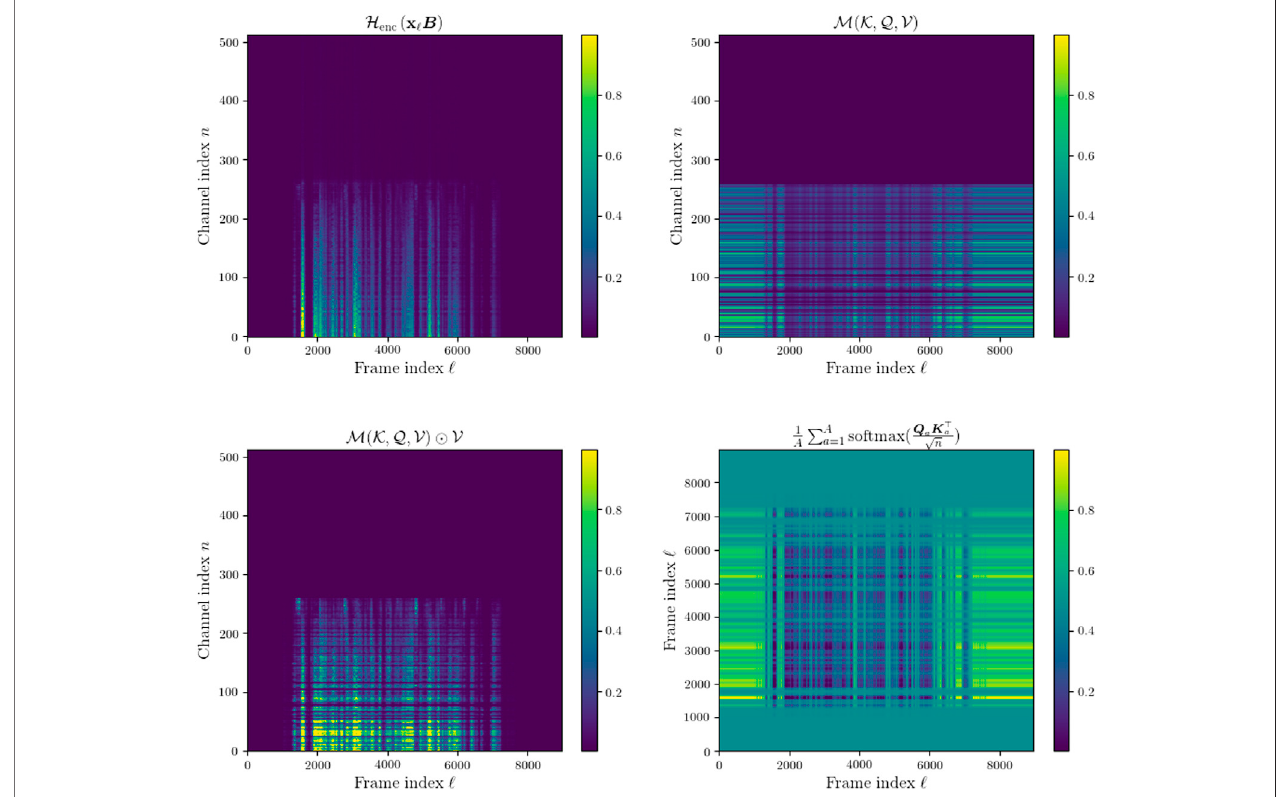
FIGURE9| Topleft: encoded CSMfeatures after 1Dconvolution andnon-linearityinMHAencoder.Topright: mask-likeoutputofselfattentive MHAlayerinMHA. Bottom left: output of the MHA encoder. Bottom right: Averaged attention weight matrix across all attention heads, A = 4.